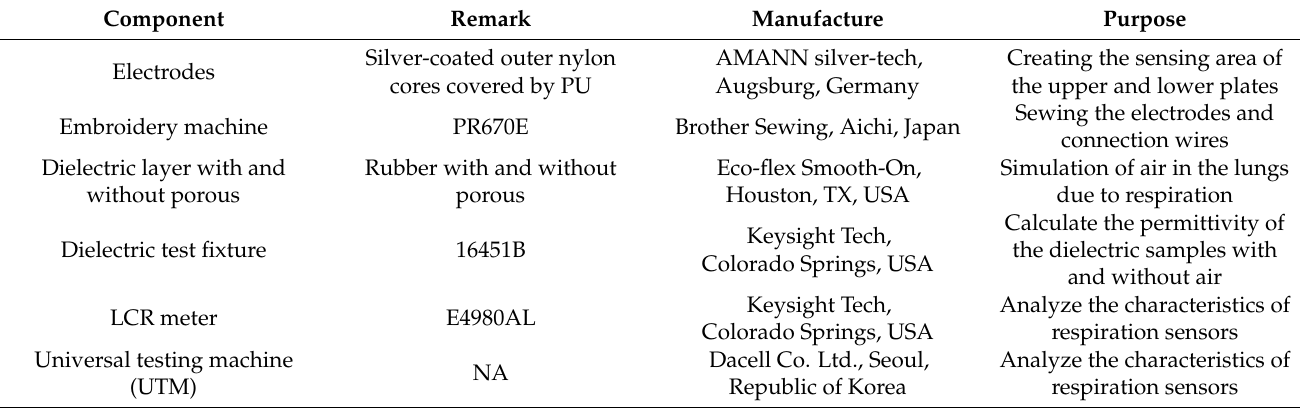
Table 3. Summary of analyzed materials and test devices used.